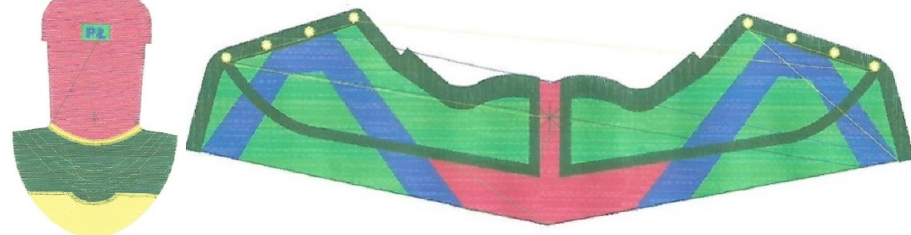
Figure 16. The embroidery design for the footwear elements obtained in the DG program by Pulse .